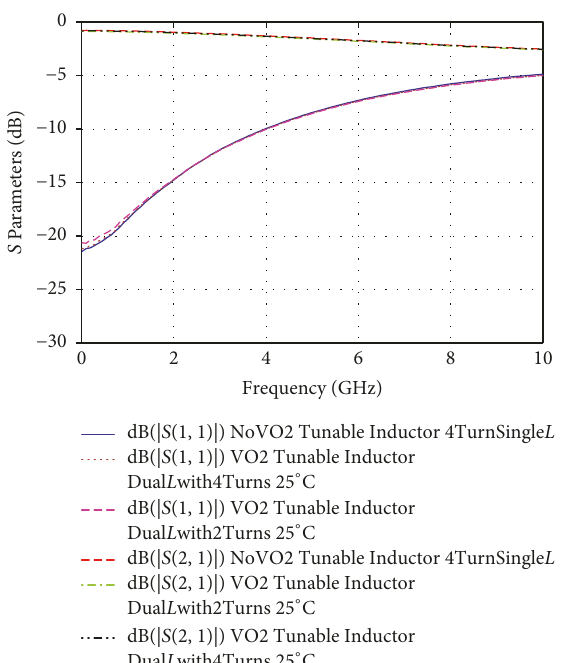
Figure 3: Measured results of 𝑆 21 magnitudes for single line coil inductor structure and dual line coil inductor structure at room temperature.